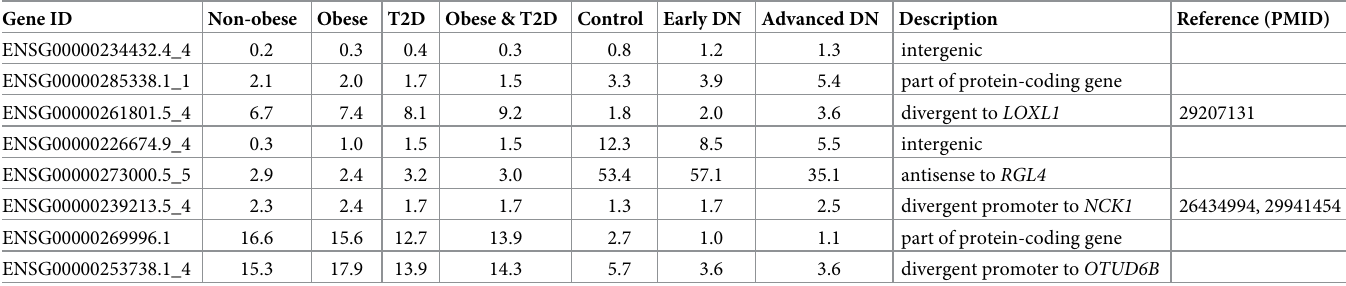
Table 3. Expression levels for each of the commonly dysregulated lncRNAs identified in both myotube and kidney samples from patients with diabetes. Gene ID